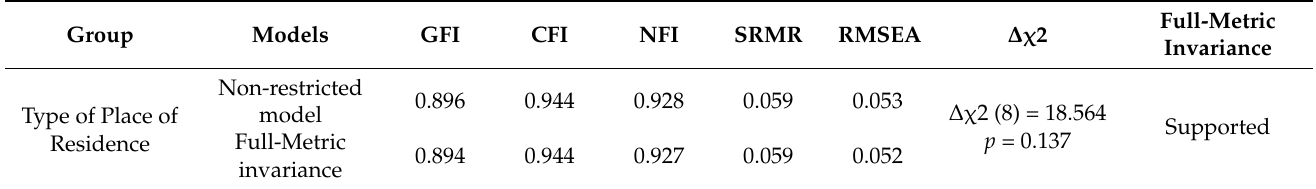
Table 5. Measurement Invariance